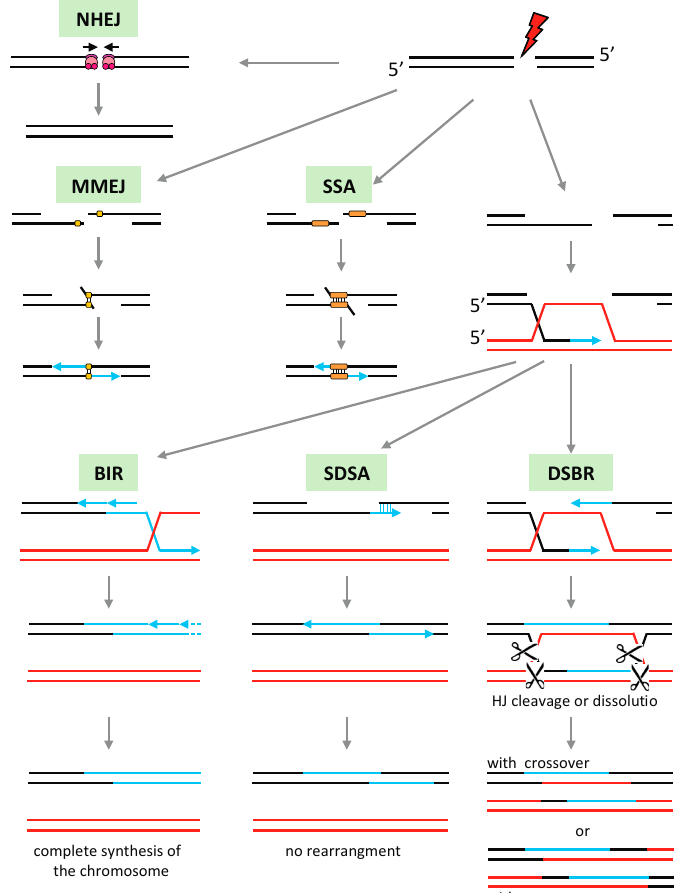
Figure 2. Repair of double-strand breaks (DSBs). The ends of a DSB can be repaired by non-faithful mechanisms independent of a recombinase. In the nucleus, non-homologous end-joining (NHEJ) involves Ku70, Ku80, and DNA-dependent protein kinase that bring together the DSB ends before they are religated. NHEJ generally leads to the suppression of several nucleotides on either side of the break. Microhomology-mediated end-joining (MMEJ) uses small homologous sequences (5–30 bp) to join both ends of a DSB and allow synthesis of missing complementary strands. By other pathways the DNA extremities are resected, giving protruding 3 ′ ends. If they contain complementary sequences they can base pair, leading to the deletion of the region between the repeats by single-strand annealing (SSA). Homology recombination (HR) pathways involve the invasion of homologous DNA by a nucleofilament of a recombinase (RecA / RAD51) bound to single-strand DNA (ssDNA). Several alternative pathways can be then followed. Double-strand break repair (DSBR) involves the recruitment of the second strand of the DSB and the formation of two Holliday junctions (HJ). The HJs can be resolved by dissolution, by branch migration towards each other and decatenation by a topoisomerase, or cleaved by a resolvase, leading to crossovers or no crossovers depending how they are resolved. By synthesis-dependent strand annealing (SDSA) the second end of the DSB is recruited after synthesis of the missing sequence using homologous DNA as template, leading to faithful repair without crossovers. The break-induced replication (BIR) pathway uses homologous DNA to re-synthesize DNA that has undergone DSB. BIR can lead to major genomic rearrangements when the homologous sequences are not allelic, such as with repeated sequences.